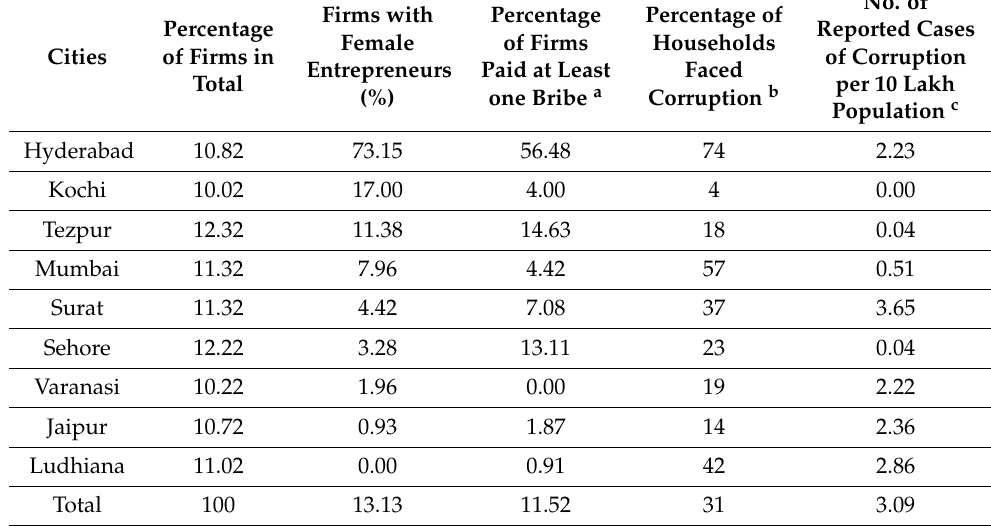
Table 3. Entrepreneurship and corruption: state profiles. No. of Percentage of Percentage Firms with Reported Cases Percentage Households of Firms Female of Corruption Cities of Firms in Faced Paid at Least Entrepreneurs per 10 Lakh Total Corruption b one Bribe a (%) Population c Hyderabad 10.82 73.15 56.48 74 2.23 Kochi